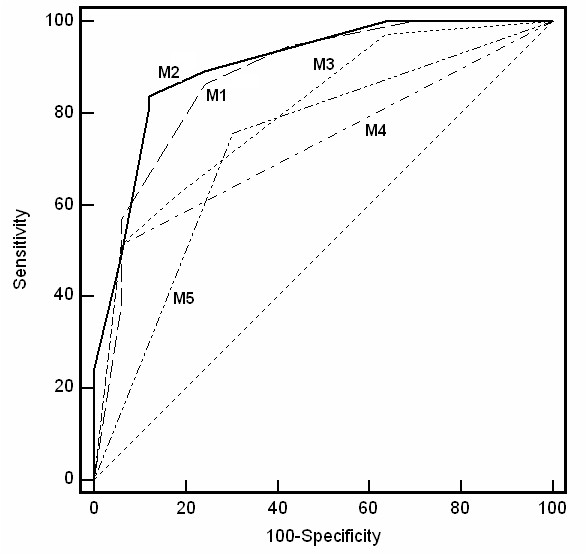
Comparative Receiver operating characteristic curves for early sepsis diagnosis. The curves relate the different models of logistic regression detailed in Table 4: M1: sepsis score >7; ACTH ≤ 233 nM/L; cortisol ≥ 450 nM/L, M2: PCT >2 ng/mL; ACTH ≤ 233 nM/L; cortisol ≥ 450 nM/L, M3: ACTH ≤ 233 nM/L; cortisol ≥ 450 nM/L, M4: PCT >2 ng/mL, M5: sepsis score >7. Sepsis score is a recommended clinico-biological multiple variable score [17,18], ACTH and cortisol baseline are a combination of two HPA biological stress parameters, and blood PCT is a gold standard biological marker of sepsis [13,50]. Respective AUC values are expressed in Table 4. The three combination panels including the two selected gold standards: sepsis score or PCT (in M1 and M2), performed for the best and similarly and offered added-value to each selected gold standard individually (that is, sepsis score (in M5) or PCT (in M4)): P = 0.005 and P < 0.001, respectively. On the other hand, adding sepsis score or PCT to the two combinations of stress parameters (ACTH, cortisol baseline) also optimized the prediction vs. ACTH and cortisol baseline: P = 0.037 and P = 0.036, respectively. Vertical axis represents the number of true positive values (sensitivity) and horizontal axis the number of false positive values (1-specificity), with the diagonal segments produced by ties.